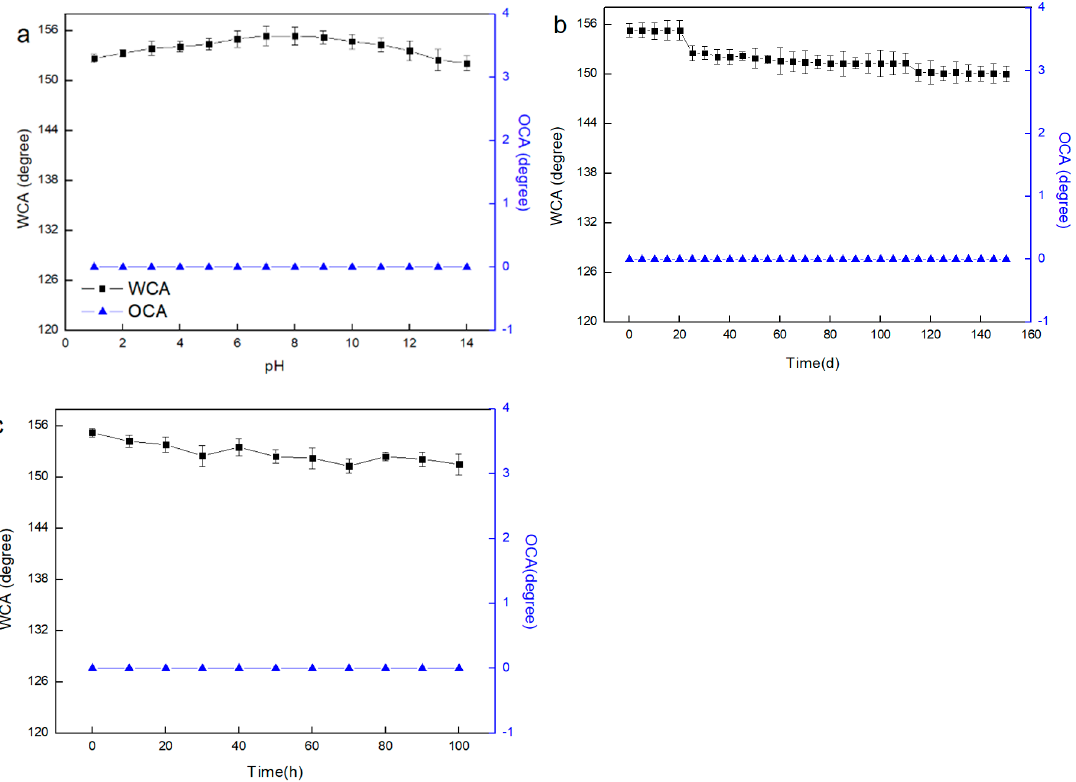
Figure 6. Change of contact angle of water (WCA) and oil (OCA) of SMSD under ( a ) different pH of aqueous solution; ( b ) long-term exposure to ambient air; ( c ) 35 °C and relative humidity of 90% condition.